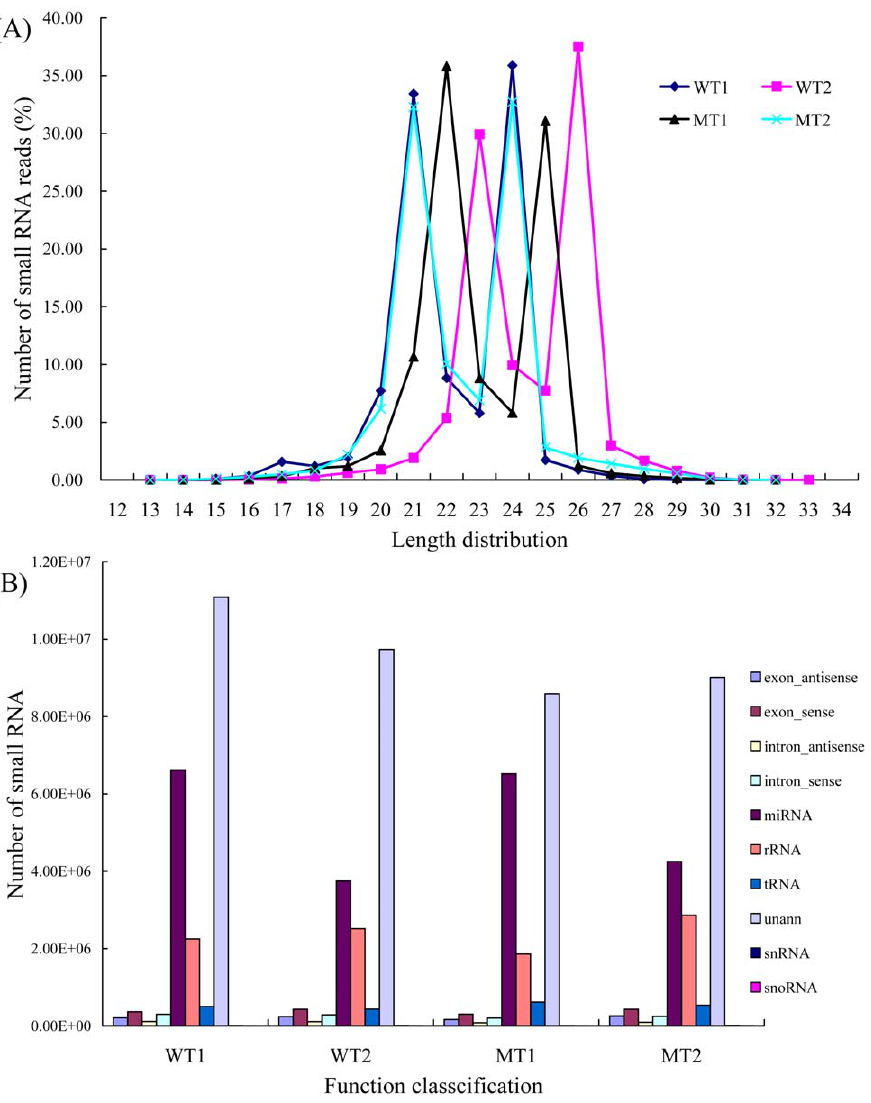
Figure 2. Length size distribution of small RNA. The length size distribution (A) and proportions of various categories (B) of small RNAs in the MT and its WT at different developmental stages.